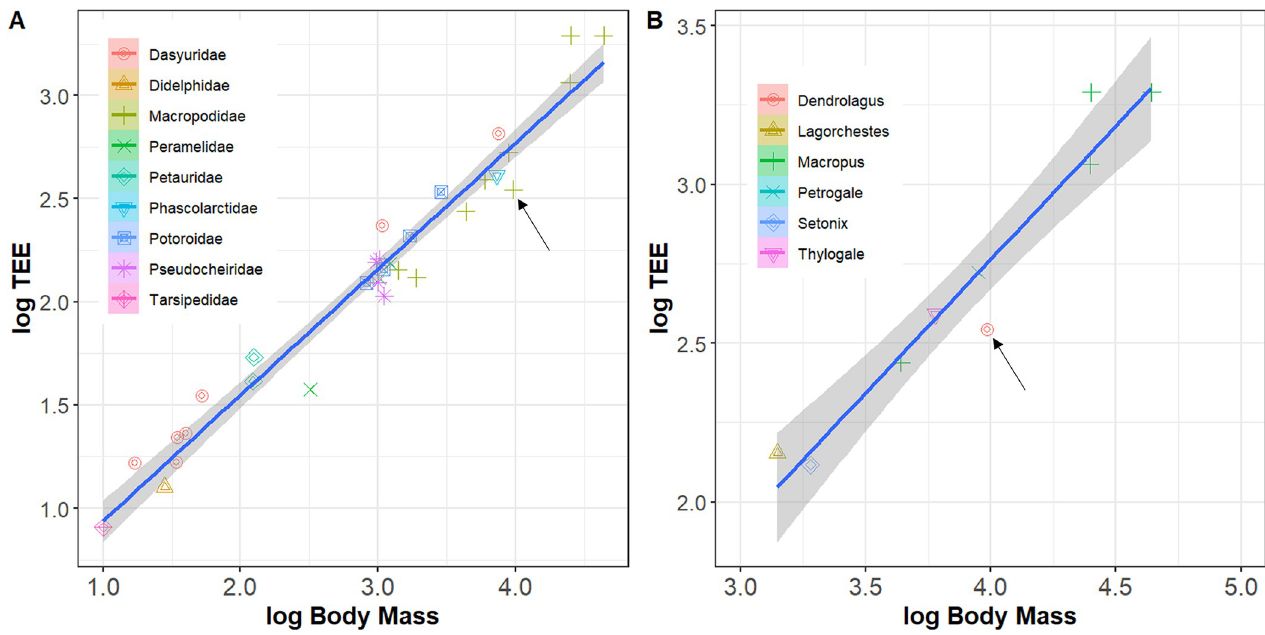
Fig 2. Comparison of TEE (kcal day -1 ) versus body mass (kg) for marsupials (A: n = 32 species organized by nine families) and Macropodidae (B: n = 9 species organized by six genera). Shaded regions indicate 95% confidence intervals for the linear regressions. Arrows indicate Matschie’s tree kangaroo ( Dendrolagus matschiei ) mean TEE value from this study. Published TEE values for 31 marsupial taxa taken from Hume [11], Munn et al. [26–28],and Sale et al. [29]. https://doi.org/10.1371/journal.pone.0270570.g002 Table 2. Macronutrient intake, fecal output, and apparent digestibility in zoo-housed Matschie’s tree kangaroos ( Dendrolagus matschiei ).